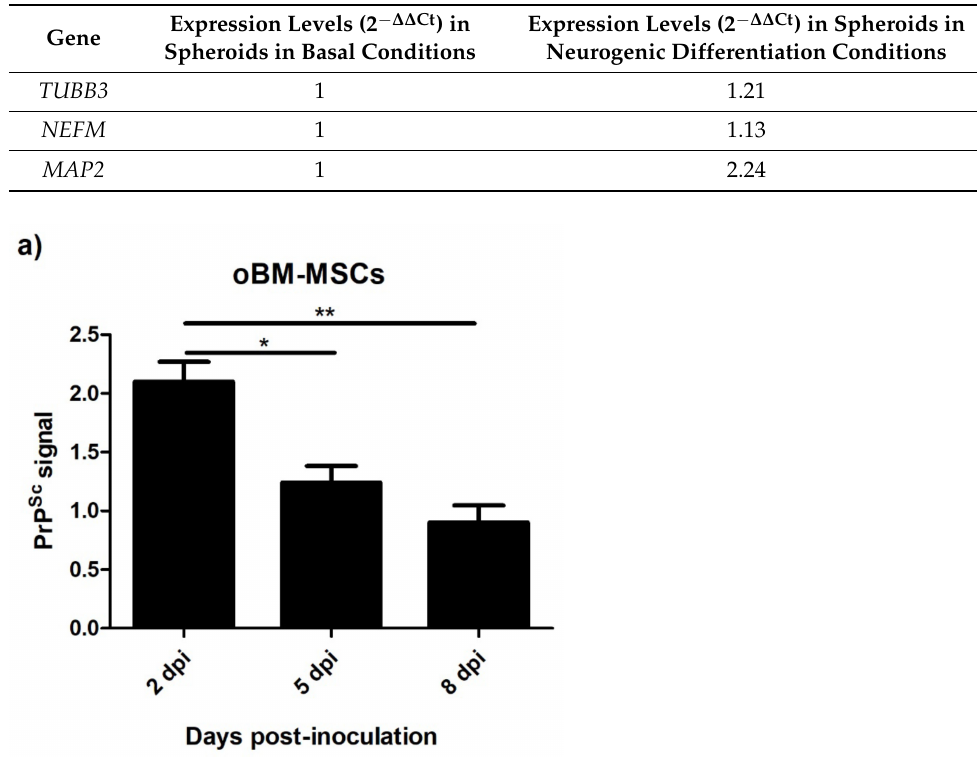
Figure 5. Spheroids in basal ( a ) and neurogenic differentiation ( b ) conditions. Cresyl violet stain- ing of spheroids in basal ( c ) and neurogenic ( d ) conditions 3 days after neuronal induction. Blue arrows indicate the prolongations formed on the contours of the spheroid and the red arrow marks the Nissl bodies. Table 2. Expression levels of neuronal markers NEFM , MAP2, and TUBB3 in spheroids in basal and neurogenic differentiation conditions 3 days after neurogenic induction. Relative expression levels are shown in terms of 2 − ∆∆ Ct .